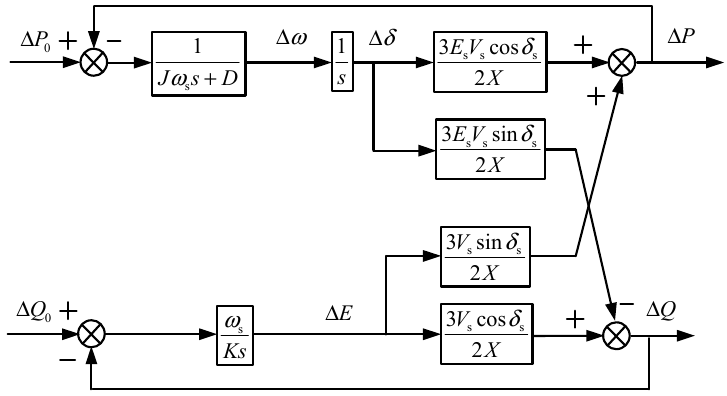
Figure 9. Small-signal modeling in response to changes in active command values.